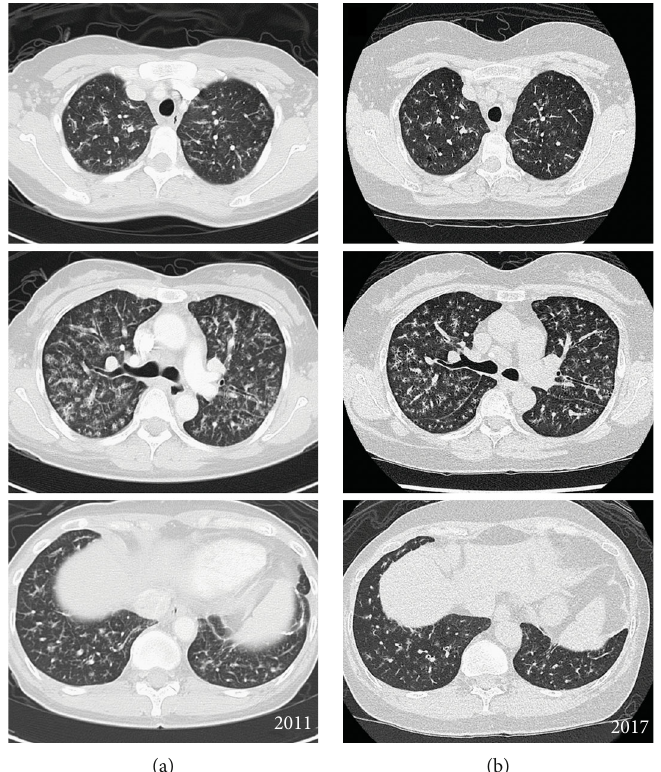
Figure 1: Selected axial CT images of the initial scan (a) and 6 years later (b) of LIP. There are di ff use peribronchovascular thickening and ground glass changes with tiny cysts along the bronchovascular bundles in both